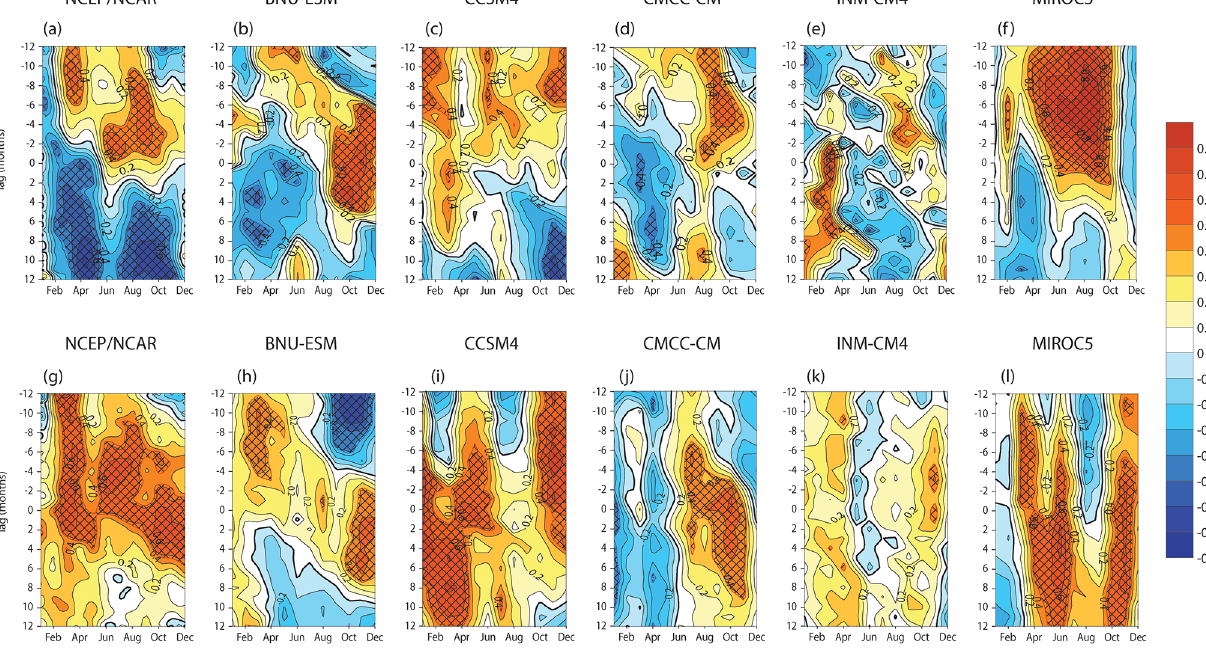
Figure 11. As Fig. 10 but for Rossby waves’ activity